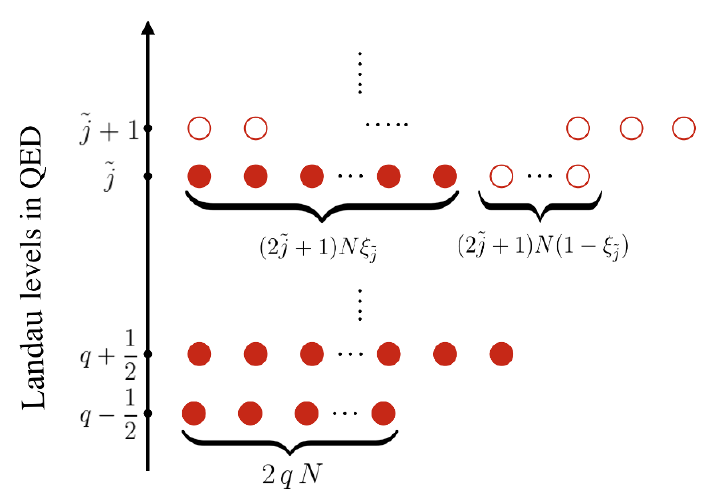
Figure 6 . Cartoon showing Landau level (cid:12)lling through the oscillator construction of the mi- crostates. As suggested by the (cid:12)lled red circles, for a given Chern-Simons level, we (cid:12)ll all the Landau levels up to ~ j and (2~ j + 1) N(cid:24) ~ modes at level ~ j j